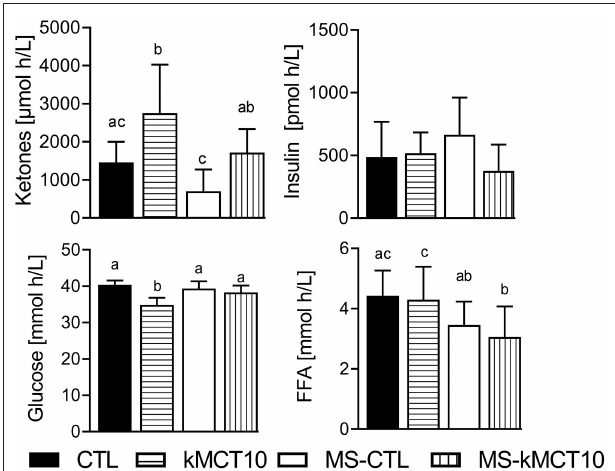
FIGURE 6 | Area-under-the-curve for the plasma ketone, glucose, insulin and free fatty acid (FFA) response over the full 8h of the metabolic study day without consuming kMCT (CTL), after 10g of kMCT (kMCT10), with no meal at T0 but a meal at T4 without kMCT (MS-CTL) or with no meal at T0 but a meal at T4 with 10g of kMCT (MS-kMCT10). Values are presented as mean ± SD ( n = 6–10). Means without a common letter differ significantly (A < B); P <